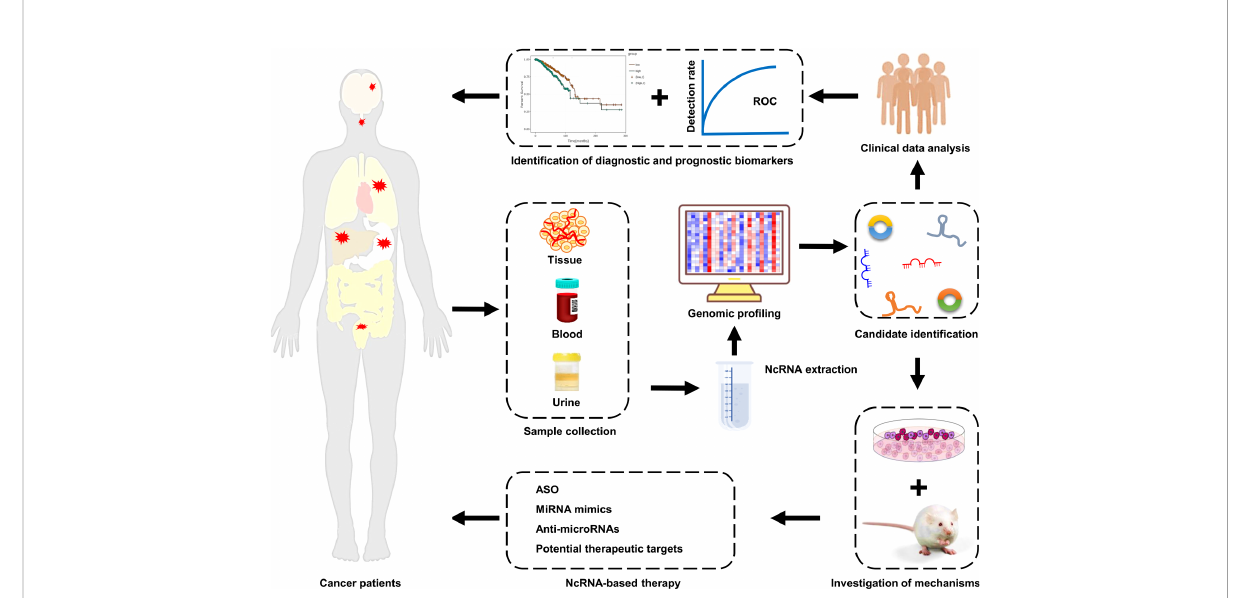
FIGURE 3 Clinical implications of ncRNAs in cancer drug resistance. NcRNAs are enriched in tissue, blood, and urine samples from cancer patients with drug resistance. The expression pro fi les of ncRNAs are mapped using high-throughput sequencing technologies. Next, the differentially expressed ncRNAs are screened and identi fi ed by bioinformatics analysis. Subsequently, the mechanisms of ncRNAs in cancer drug resistance are elucidated using cell and animal models. The aberrantly expressed ncRNAs that possessed great potential as biomarkers and/or therapeutic targets are identi fi ed. Finally, cancer patients, particularly those with drug resistance, receive the individualized precision treatment